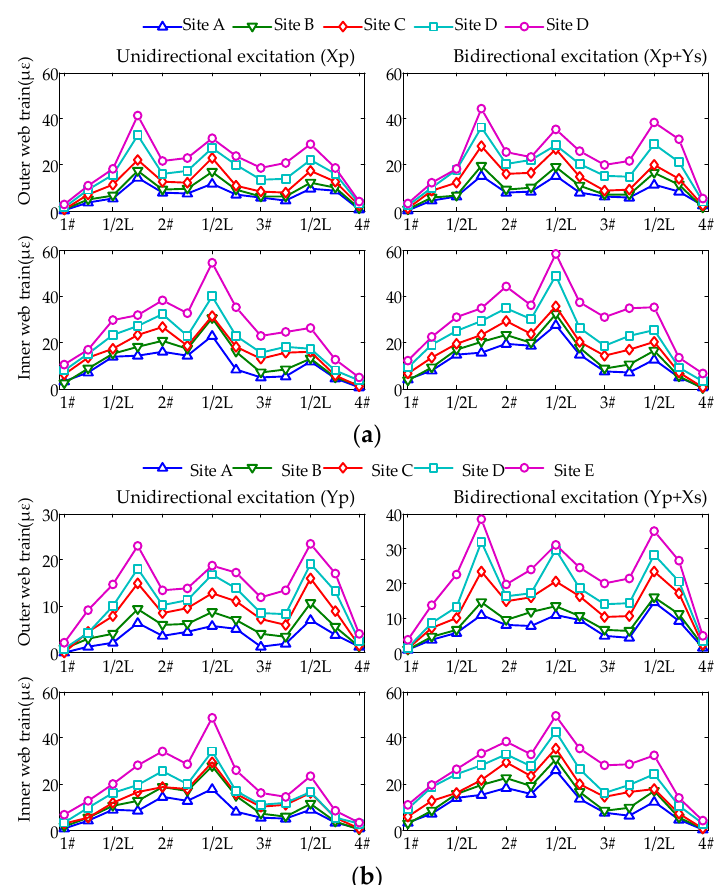
Figure 9. Web strain of girder: ( a ) position A: curved bridge parallel to the direction of the principal ground motion; ( b ) position B: curved bridge perpendicular to the direction of the principal ground motion.